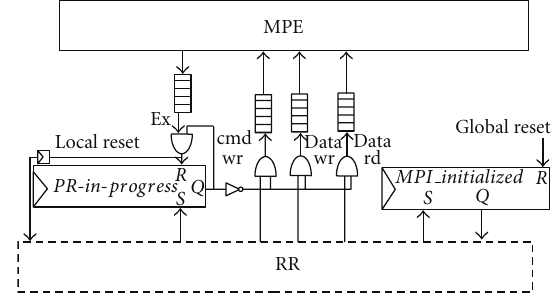
Figure 6: Static registers and decoupling logic between SR and